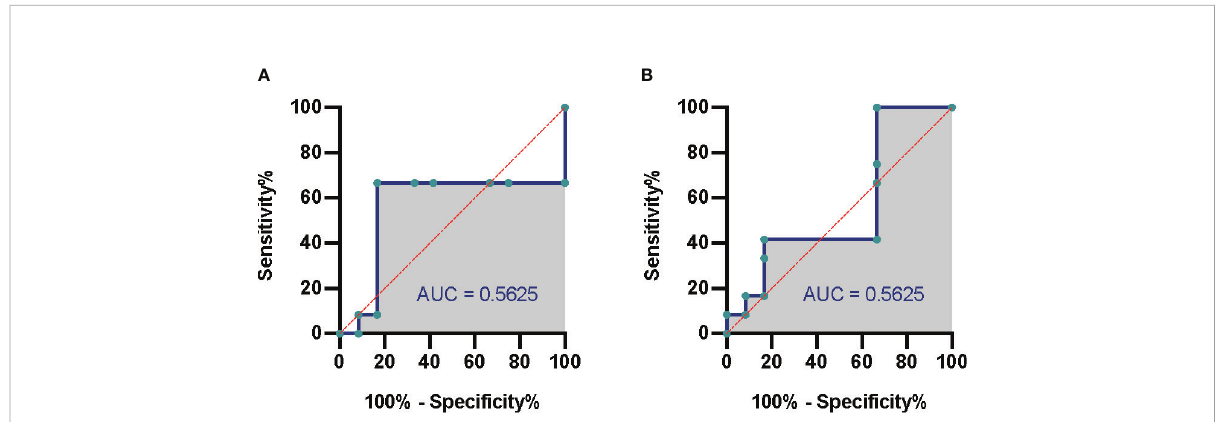
FIGURE 3 Comparison of mNGS and conventional culture method. The ROC of septic CSI patients under different cultural conditions. (A) Blood culture. (B) Combined culture. N = 27. mNGS, metagenomic next-generation sequencing; ROC, receiver operating characteristic; CSI, cervical spine